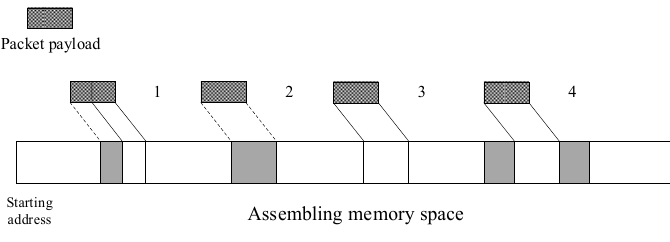
Figure 5. The four situations in process of assembling.